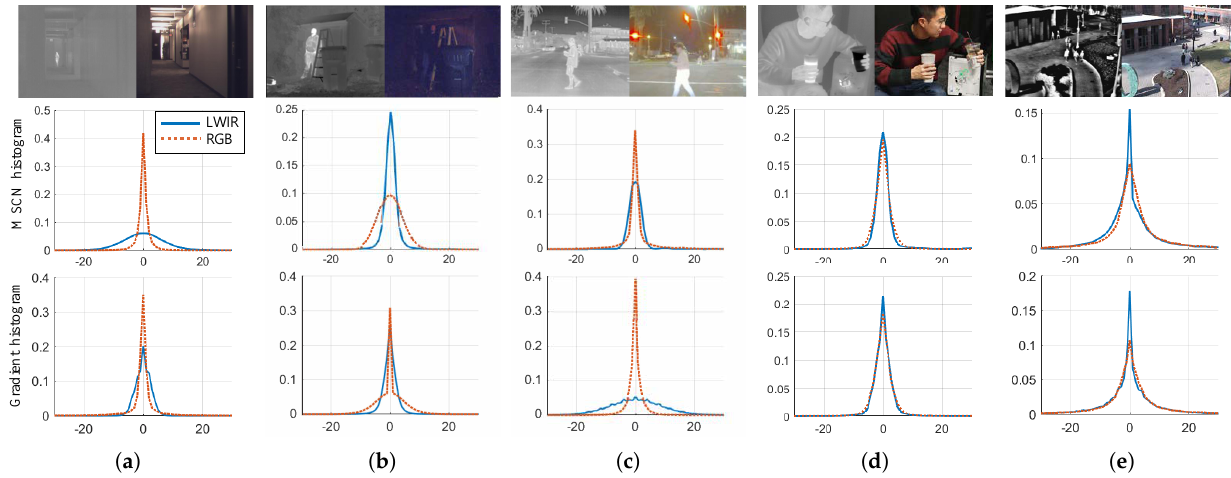
Figure 1. Test images of the five LWIR databases. The first row demonstrates different spectral images, thermal image, and visible light image, respectively. The second and third rows demonstrate the histogram and the histogram of the gradient distribution, respectively. Despite of their comparable field of view, the MSCN and the gradient distributions of LWIR and visible light images have been observed differently in most cases. ( a ) MORRIS [1]; ( b ) KRISTO [19]; ( c ) FLIR ADAS [5]; ( d ) SRIP; ( e ) OSU